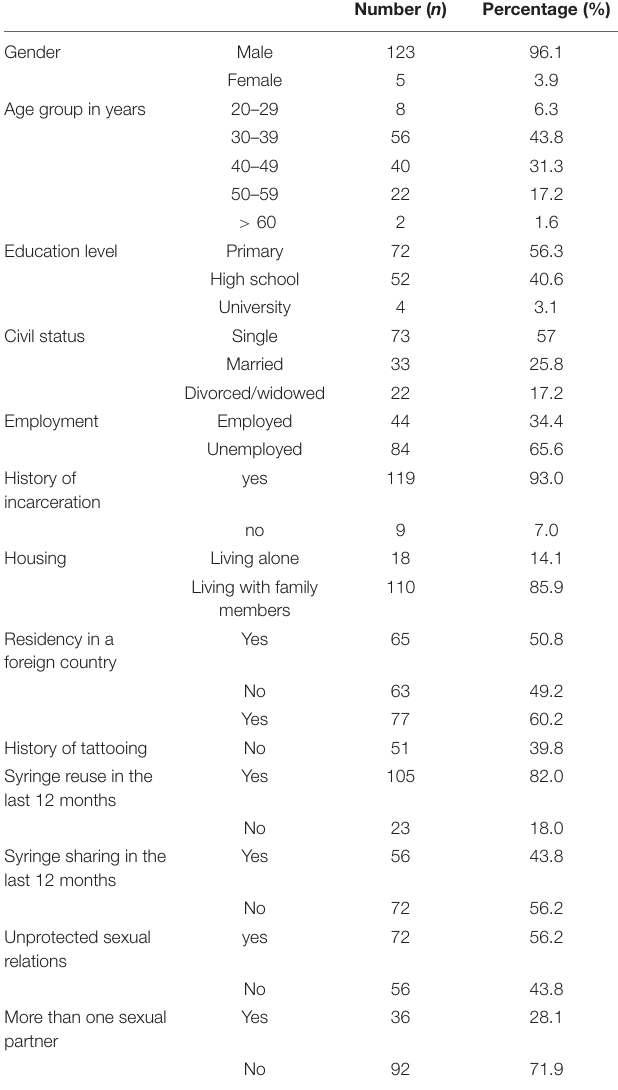
TABLE 1 | Sociodemographic characteristics and risk behaviors of hepatitis C virus (HCV)-positive people who inject drugs (PWID) attending harm reduction centers in the North Eastern region of